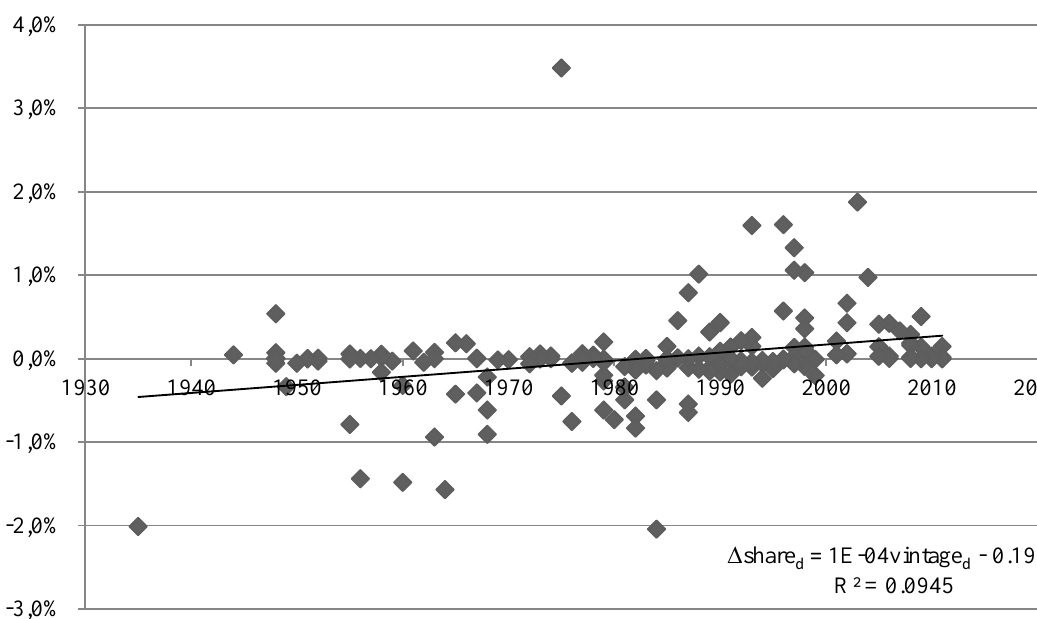
Figure 2: Relationship between drug vintage and 2003-2012 change in its share of cardiovascular drug prescriptions